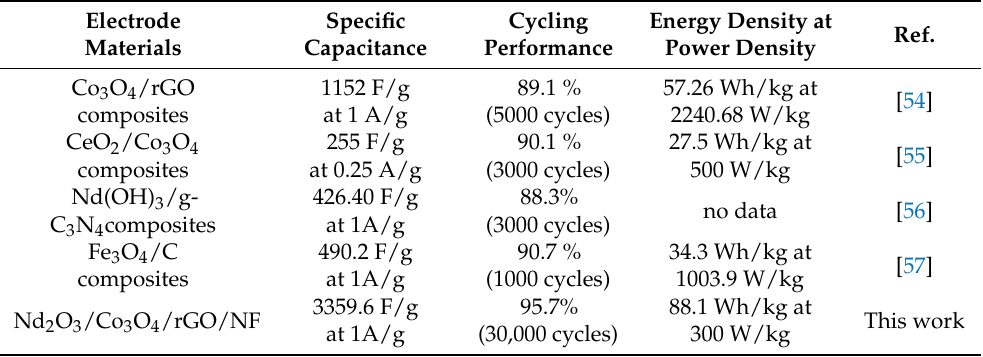
Table 1. Comparison of electrochemical performances of Nd 2 O 3 /Co 3 O 4 /rGO/NF composite elec- trode in our work with previous